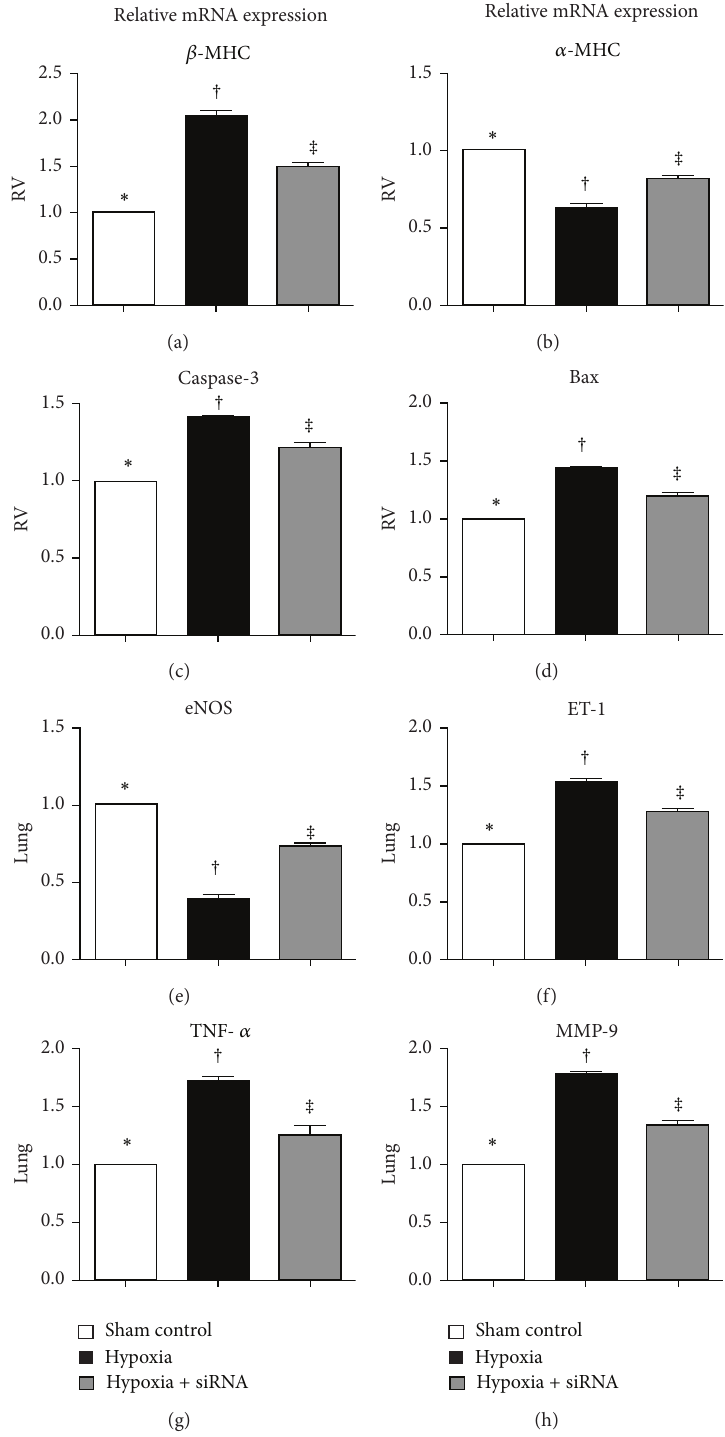
Figure 10: mRNA expressions of fibrotic and apoptotic biomarkers in lung parenchyma and right ventricle (RV) by day 28 after hypoxia- induced pulmonary arterial hypertension (PAH) ( 𝑛 = 10 ). ((a) to (d)) mRNA expressions of (a) 𝛽 -myosin heavy chain (MHC), (b) 𝛼 -MHC, (c) caspase-3, and (d) Bax in RV myocardium. ∗ versus other groups with different symbols ( ∗ , † , ‡ ), all 𝑃 values in ((a) to (d)) < 0.001. ((e) to (h)) mRNA expressions of (e) endothelial nitric oxide synthase (eNOS), (f) endothelin (ET-1), (g) tumor necrotic factor (TNF)-1 𝛼 , and (h) matrix metalloproteinase- (MMP-) 9 in lung tissues. ∗ versus other groups with different symbols ( ∗ , † , ‡ ), all 𝑃 values in ((e) to (h)) < 0.001. Statistical analysis in ((a) to (h)) using one-way ANOVA, followed by Bonferroni multiple comparison post hoc test. Symbols ( ∗ , † , ‡ ) indicate significance (at 0.05